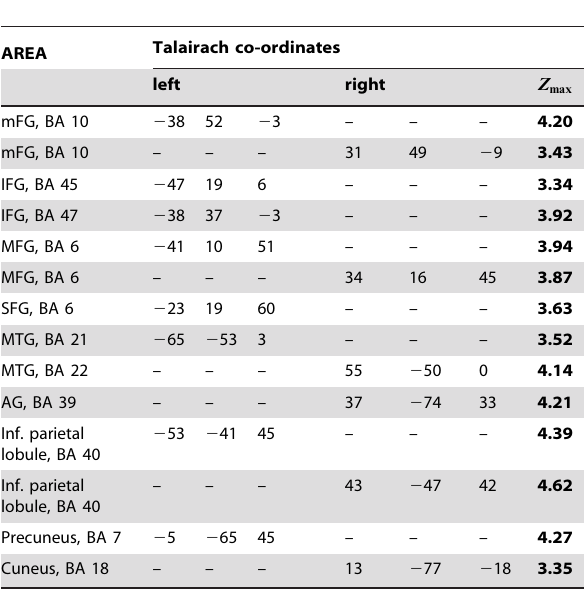
Table 1. Hierarchical correct vs. List